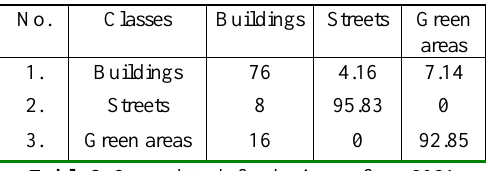
Table 3 . Ground truth for the image from 2021